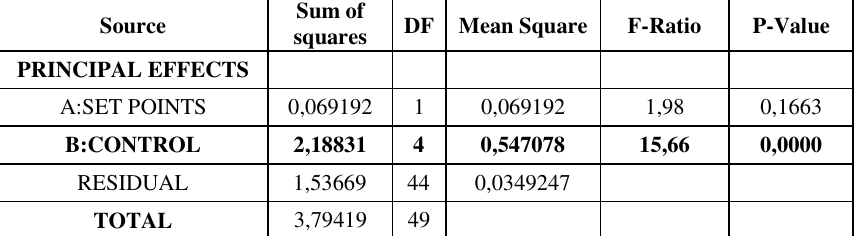
Table 3 ( A ). Analysis of Variance for MSE (sum of squares type III).